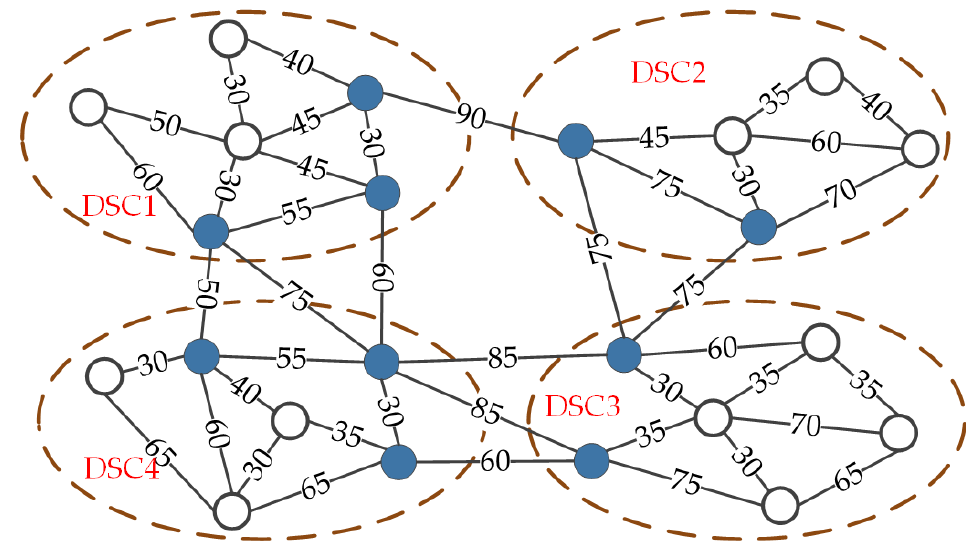
Figure 2. Test network topology in simulation.